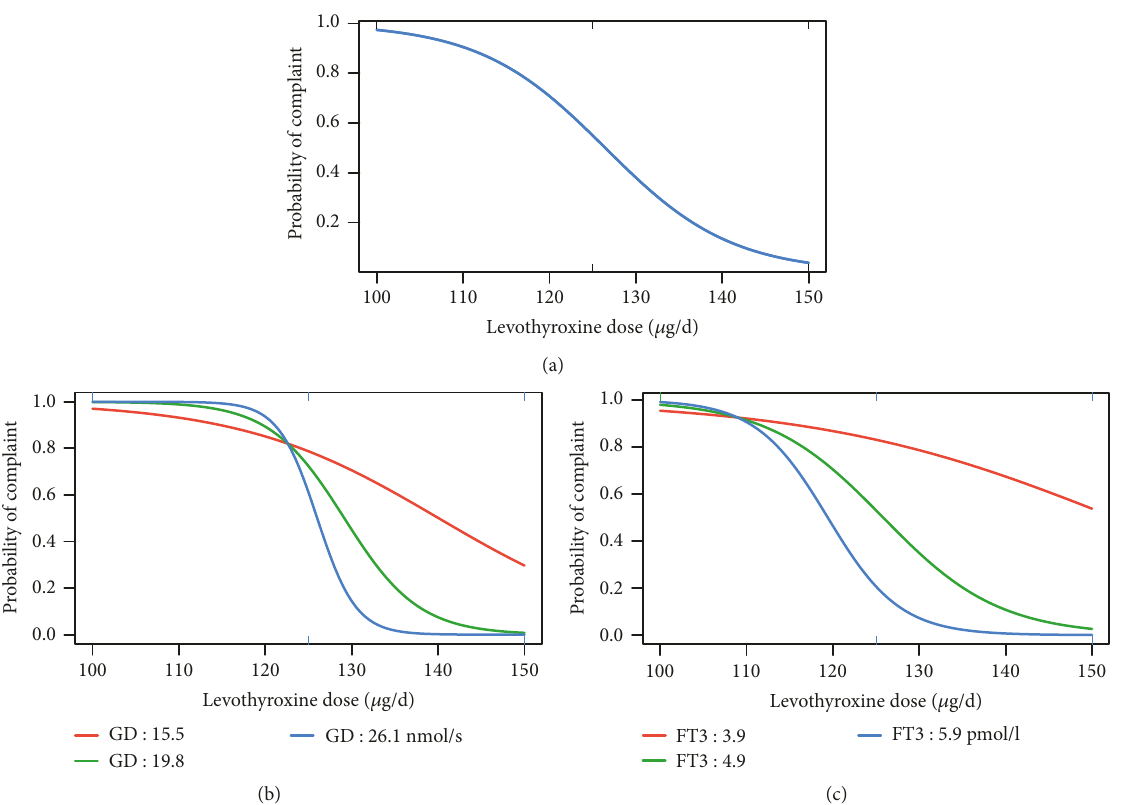
Figure 1: Demonstration of bias by data amalgamation in predicted probability of persisting hypothyroid complaints in response to LT4 dose changes depicted by a simulated trial. Group-level effect (a) is not predictive of individual responses with shifted response curves between patients displaying varying conversion rates (GD (b)), and FT3 concentrations (c). Variable patient individuality of response may impact the averaged outcome in a trial and should be accounted for in the analysis. For the purpose of this demonstration, complementing a study, which has been reported elsewhere [11], we resampled 60 follow-up visits from patients who reported relief of former complaints after LT4 dose increase within a range of 100 to 150 𝜇 g/d to generatethe structure of an extended generalised linear mixed-effects model [18]. GD refers to global deiodinase activity, a measure of T4 to T3 conversion similar to the molar T3-T4 ratio